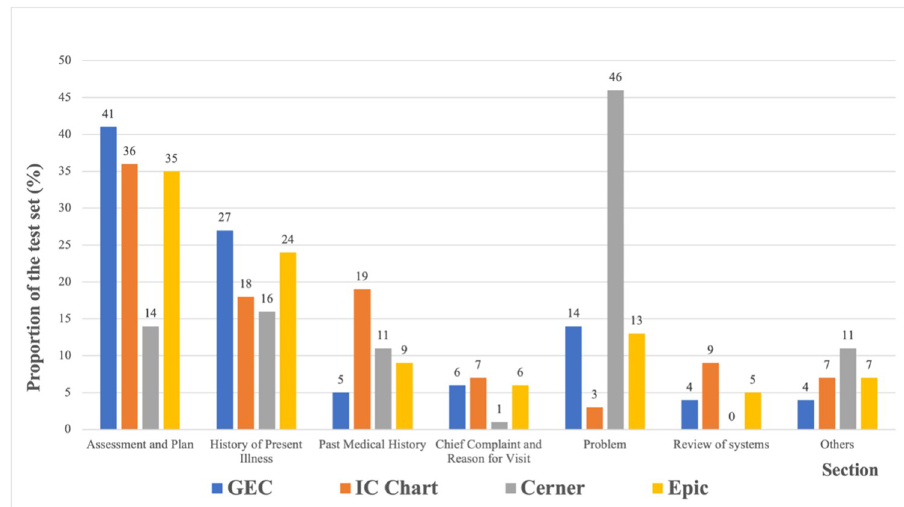
Fig 3. The distribution of the sections and subsections in the test. GEC = General Electronic Centricity EHR.